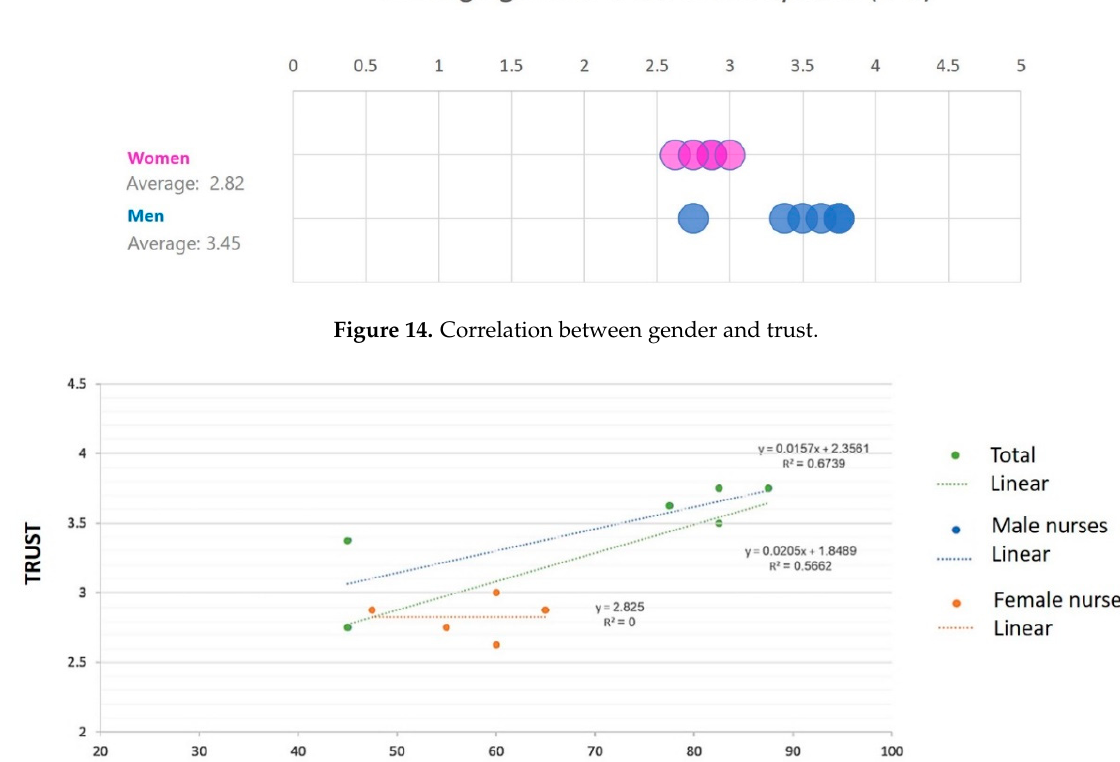
Figure 14. Correlation between gender and trust.